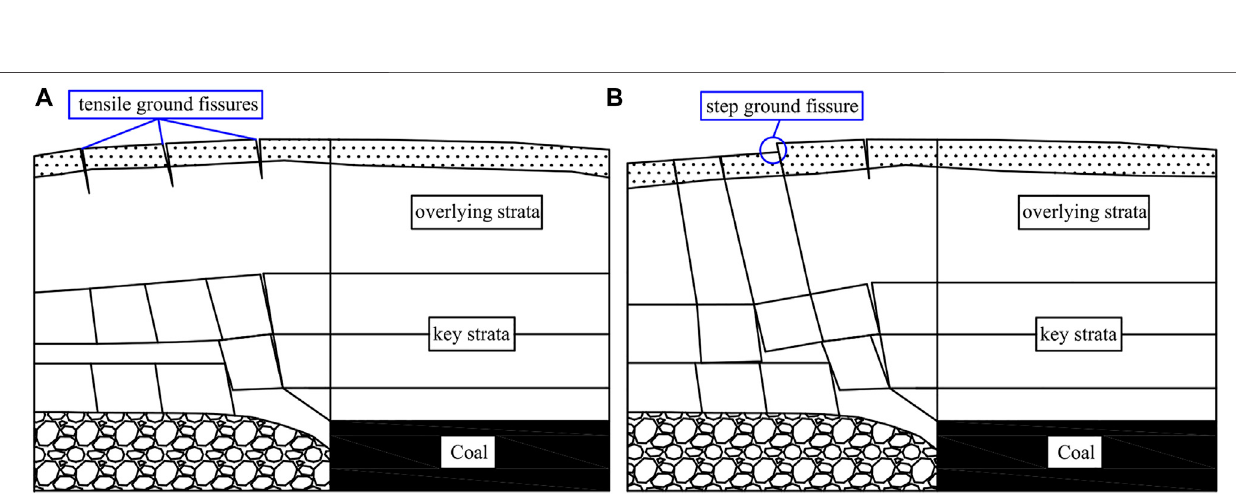
Frontiers in Environmental Science |